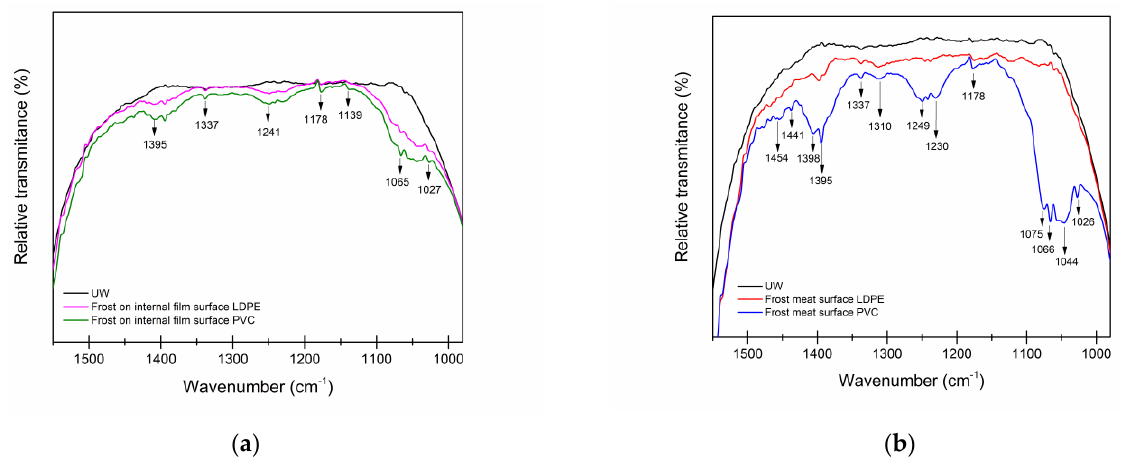
Figure 5. Infrared spectrum of frost water on the ( a ) surface of LDPE and PVC containers and ( b ) surface of meat packaged in LDPE and PVC, in contrast to ultra-pure water.